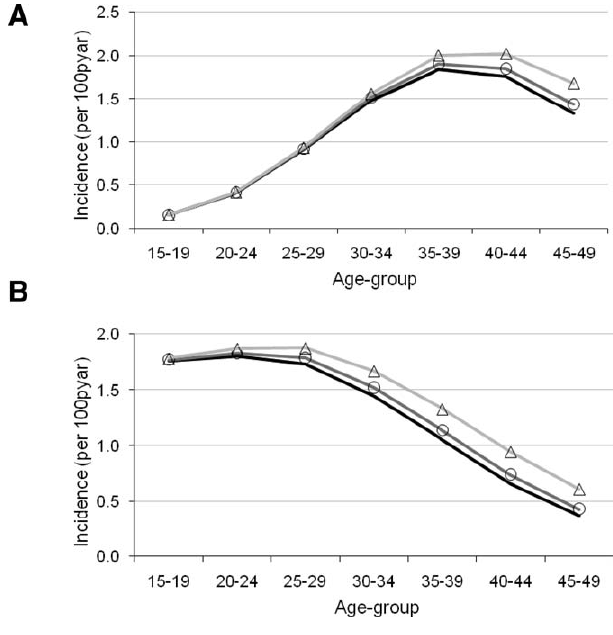
Figure 5. Incidence Estimates Using Method 2 Assuming that Provision of Antiretroviral Therapy is Scaled Up from 0% to 30% over Five Years The grey line with circles shows the estimate of incidence based on surveys before and after the 5-y scale-up; the grey line with triangles shows the estimate of incidence based on surveys after scale-up, while provision is maintained at 30%. The black line shows the estimates if ART is not provided. Graphs show the simulations assuming that the incidence rate is highest at (A) older ages and (B) young ages. Similar results are obtained using method 1.